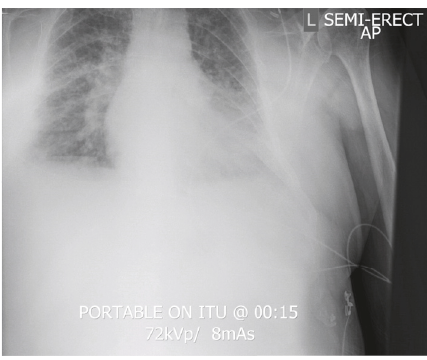
Figure 1: Preintubation CXR shortly after ICU admission.